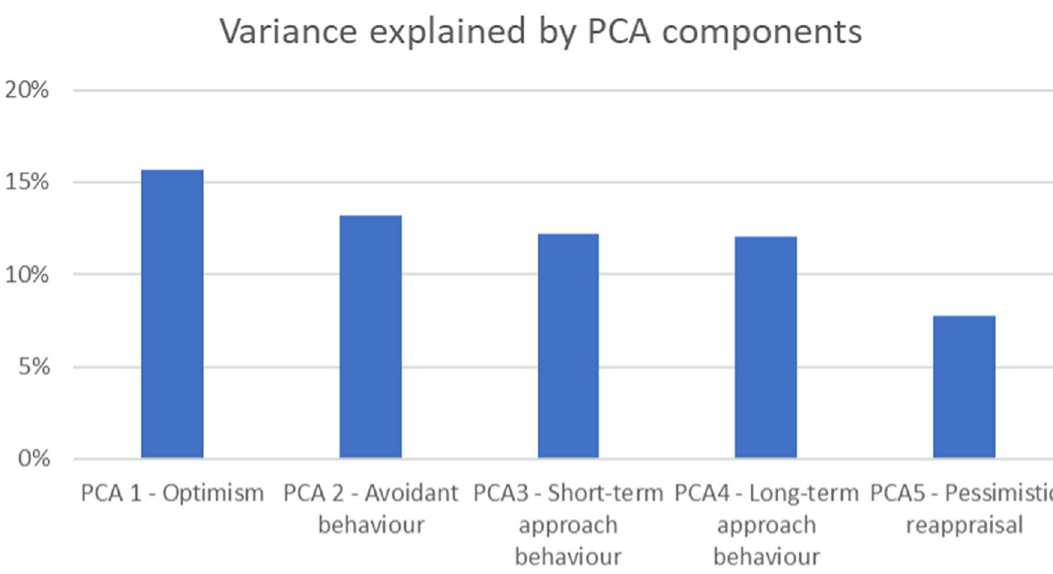
Figure 1. Total variance explained (60.8%) by the five PCA components with an eigenvalue > profile, onto which LOT Optimism, COS optimism and SWLS loaded positively and LOT Pessimism loaded negatively; (b) “ Short-term approach behavior ” profile, onto which Extraversion, Agreeableness and BAS Fun Seeking loaded positively and EQ Suppression loaded negatively; (c) “ Long-term approach behavior ” profile, onto which BAS Drive, BAS Reward Responsiveness and, to a lesser degree, BAS Fun Seeking and Openness loaded. We found that the “ Optimism ” profile correlated positively with AD values in white matter tracts exclusively in the right hemisphere: the CST, the SLF, and the anterior CNG, CC and ATR. Similar to FA values, the AD reflects the magnitude of diffusion parallel to fiber tracts and thus the integrity of axons 77,78 . The exclusivity of our findings in the right hemisphere is in line with the proposed functional asymmetry between the left and right hemispheres concerning complementary modes of processing incoming information (e.g. 79,80 ). While the left hemisphere processes the information in a strictly sequential and unambiguously understood monosemantic context 81 , the function of the right hemisphere is to simultaneously capture a vast number of possible connections and to integrate them in an ambiguous but polysemantic context 81–83 . Because of this functionality, the right